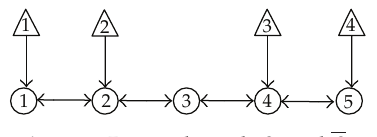
Figure 2: Directed graph G 2 and G 2